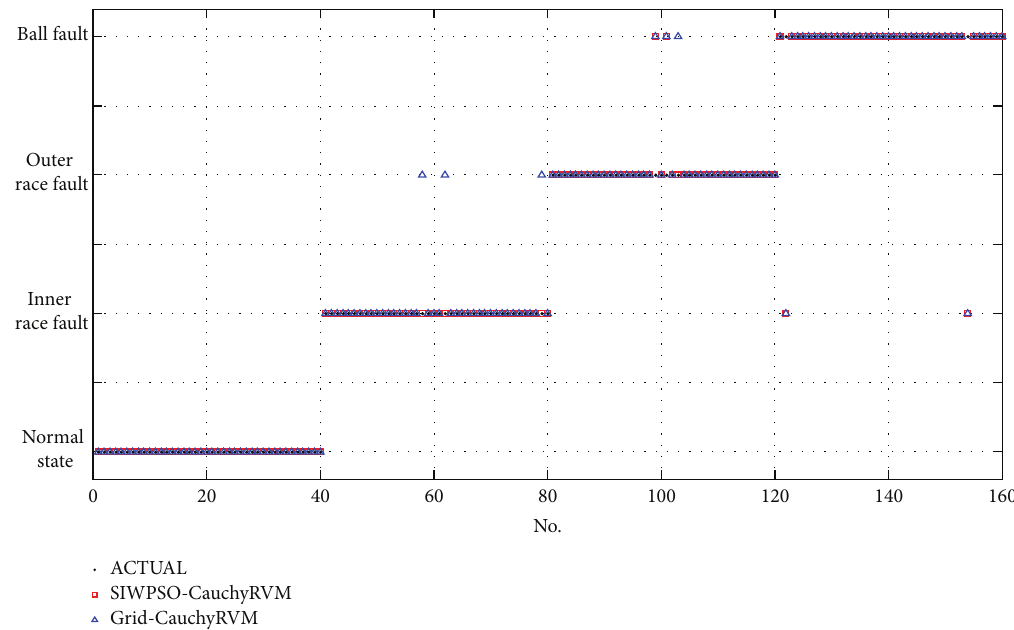
Figure 5: The comparison of the diagnosis results between SIWPSO-CauchyRVM and Grid-CauchyRVM in experiment 2.